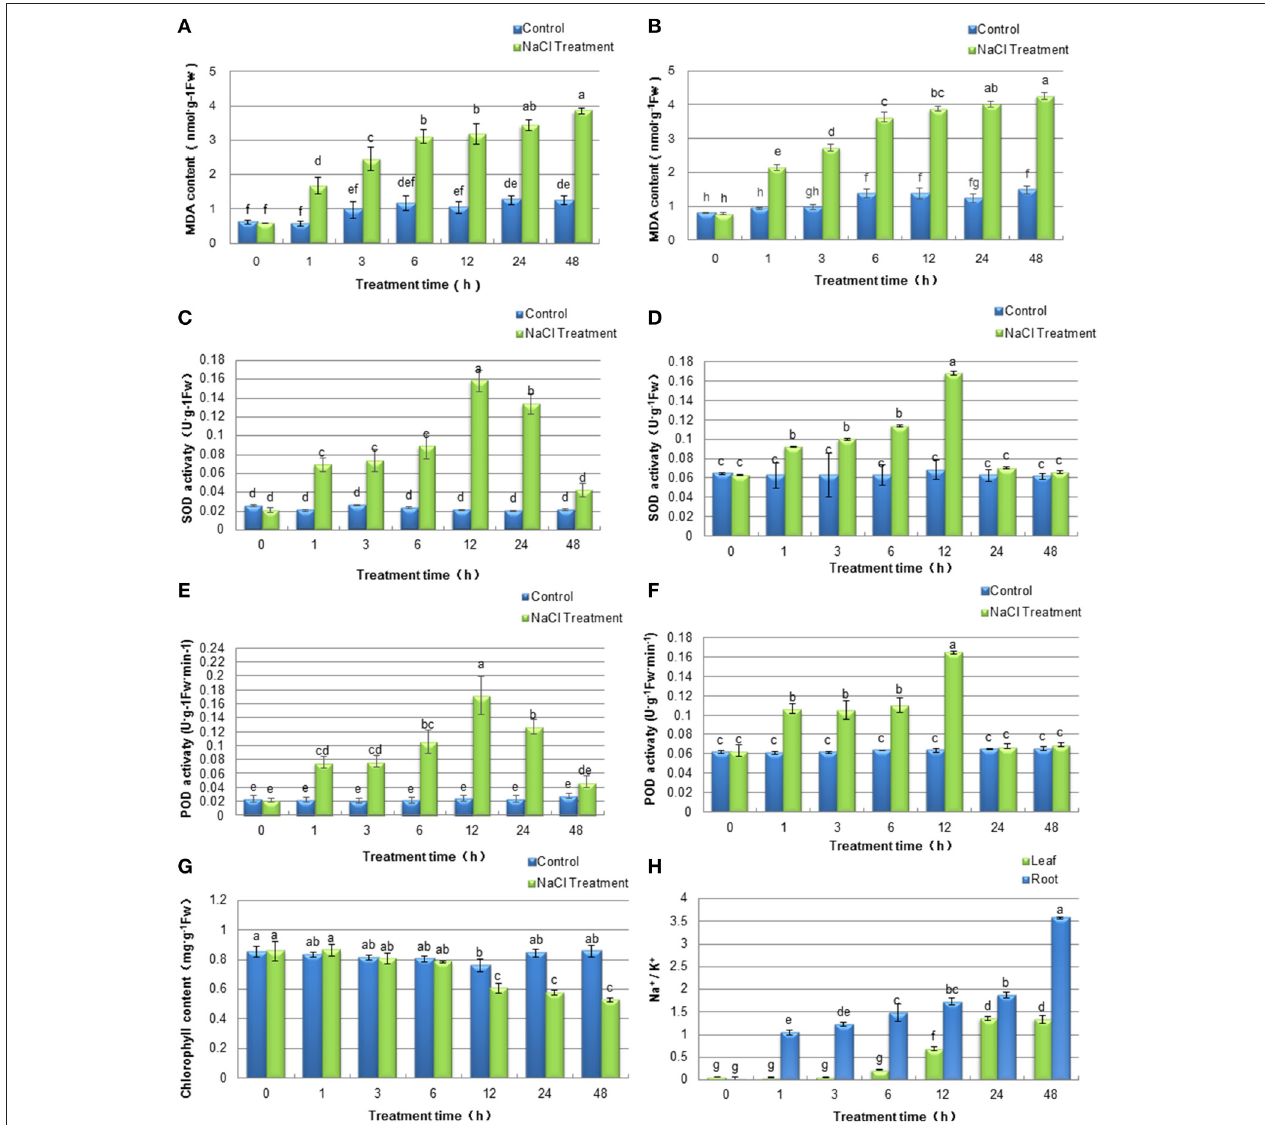
FIGURE 2 | Effects of salinity stress on physiological characteristics of soybean leaves and roots. Soybean seedlings were treated with 200mM NaCl for 0 (control), 1, 3, 6, 12, 24, 48h. The values represented the mean ± SD of three biological replicates. The different letters above columns indicated significant differences among different treatment time of soybean plants based on one-way ANOVA ( p < 0.05). (A,B) MDA contents of soybean leaves and roots respectively; (C,D) SOD activities of soybean leaves and roots respectively; (E,F) POD activities of soybean leaves and roots respectively; (G) Chlorophyll content of soybean leaves; (H) Na + /K + ratios of soybean leaves and